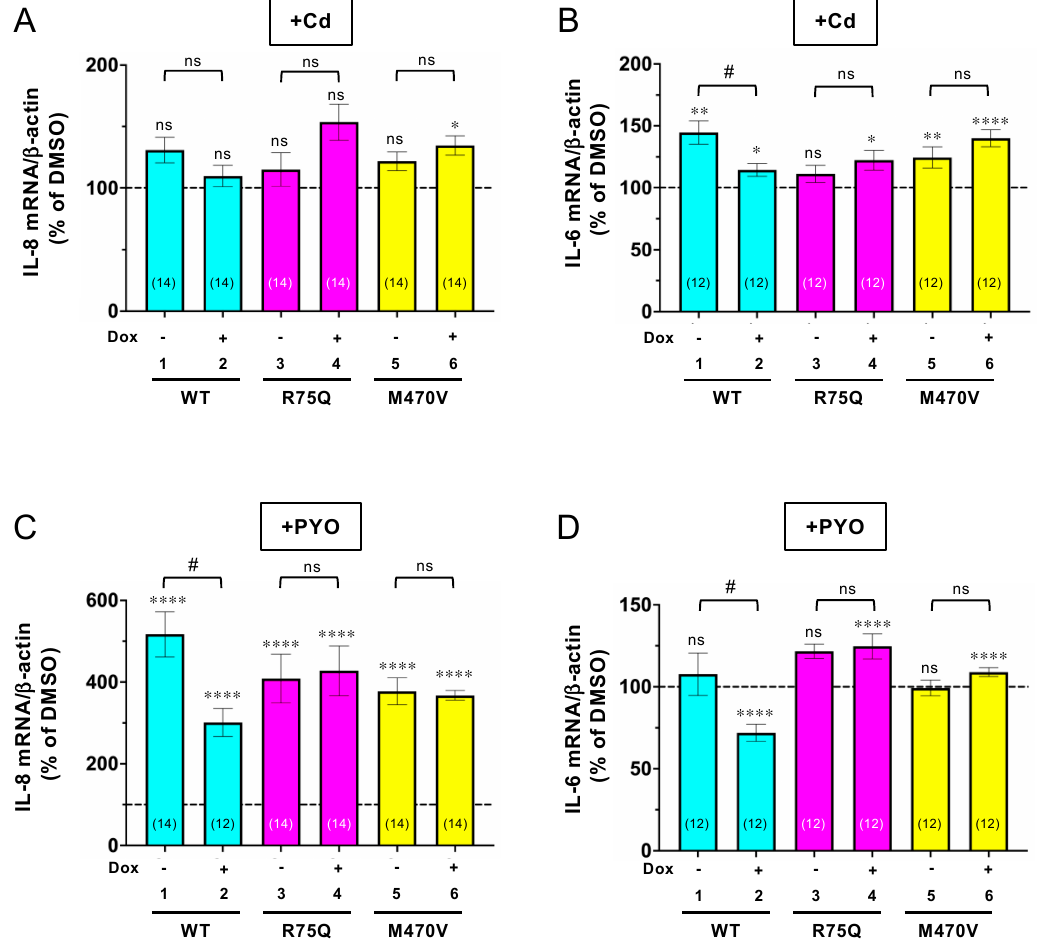
Figure 3. WT-CFTR, but neither R75Q nor M470V-CFTR, suppressed the Cd- or PYO-induced pro- inflammatory cytokine mRNA expression in CFBE Tet-on cells. CFBE Tet-on cells expressing WT-, R75Q-, or M470V-CFTR were treated with 15 µM Cd ( A , B ) and 5 µM PYO ( C , D ) for 3 days. At the same time, the cells were treated with or without Dox (1 µg/ml) for 3 days. Cd or PYO-induced mRNA expression of IL-8 was analyzed by RT-qPCR. Data represent mean±SE. n.s., not signifi- cant; * p < 0.05, ** p < 0.01, **** p < 0.0001 vs. each DMSO ( t -test). # p < 0.05 vs. no Dox ( t -test). The number of data from at least two independent experiments is indicated in parentheses.